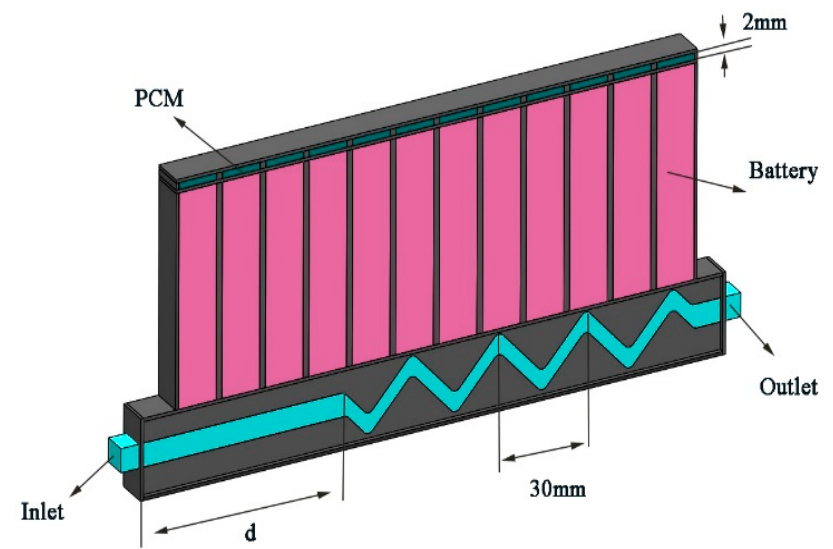
Figure 12. Schematic diagram of composite-channel/PCM design.